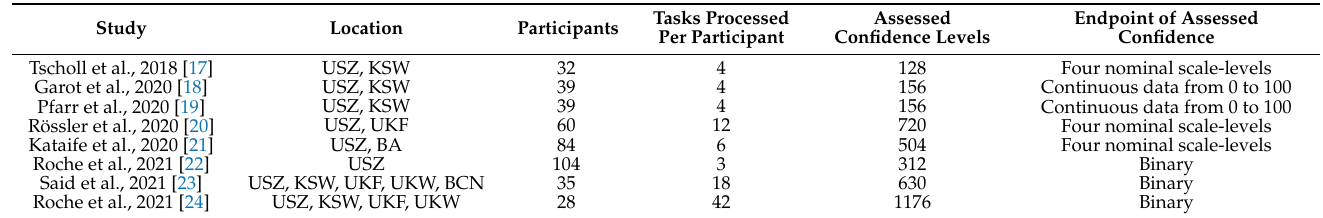
Table 1. Summary of the eight studies analyzed. Self-assessed confidence was collected in each study after the completion of a specific task using either a new or an established technology. For further analysis, we defined the endpoint of self-assessed confidence of the eight studies as a binary value (confidence below the median versus confidence at or above the median). User-centered technologies were Visual Patient, Visual Clot, Haemostasis Traffic Light, Voice alerts, and auditory icons.